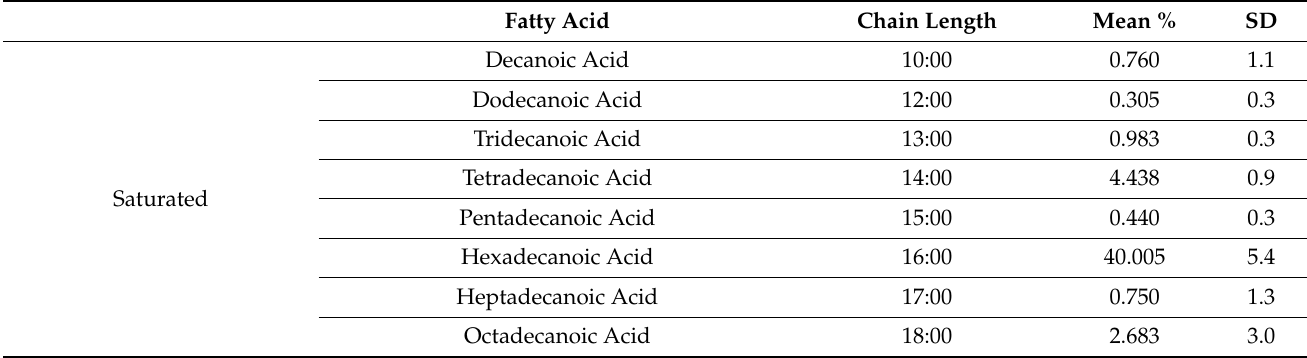
Table 1. Fatty acid composition (relative abundance, % over total fatty acids) of Agarophyton chilense oleoresin (Gracilex ® ). Fatty acids were detected as methyl fatty acids by GC-FID. Results are expressed as mean and standard deviation (SD) of the mean of six independent Gracilex ® preparations. Fatty acids were detected as methyl fatty acids by GC-FID. Mean of six lipid extracts produced from independent algal biomass harvested and cultured in different seasons (fall, winter, and